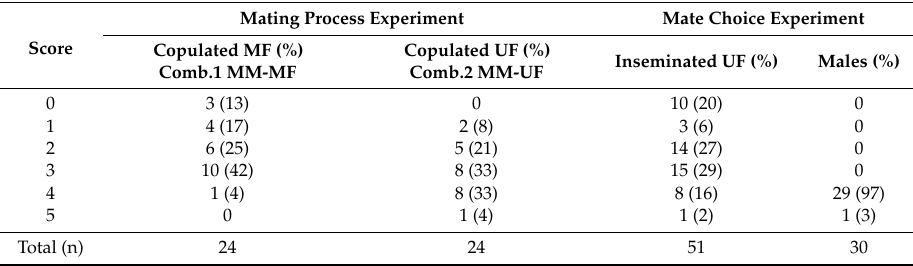
Table 3. Powder score in females.